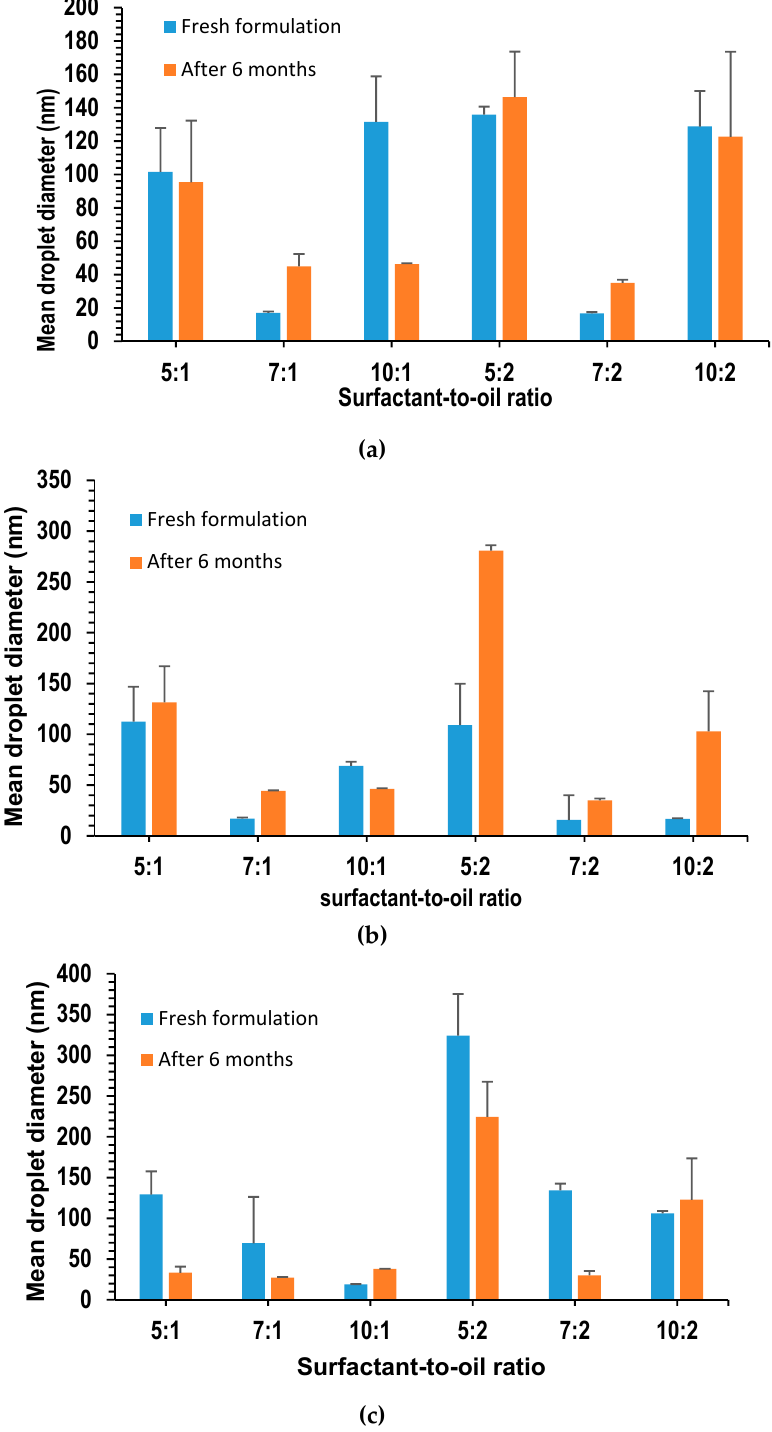
Figure 7. Droplet size of lidocaine-loaded nanoemulsions with ( a ) beeswax; ( b ) coconut oil; ( c ) oleic acid; freshly prepared and after 6 months.